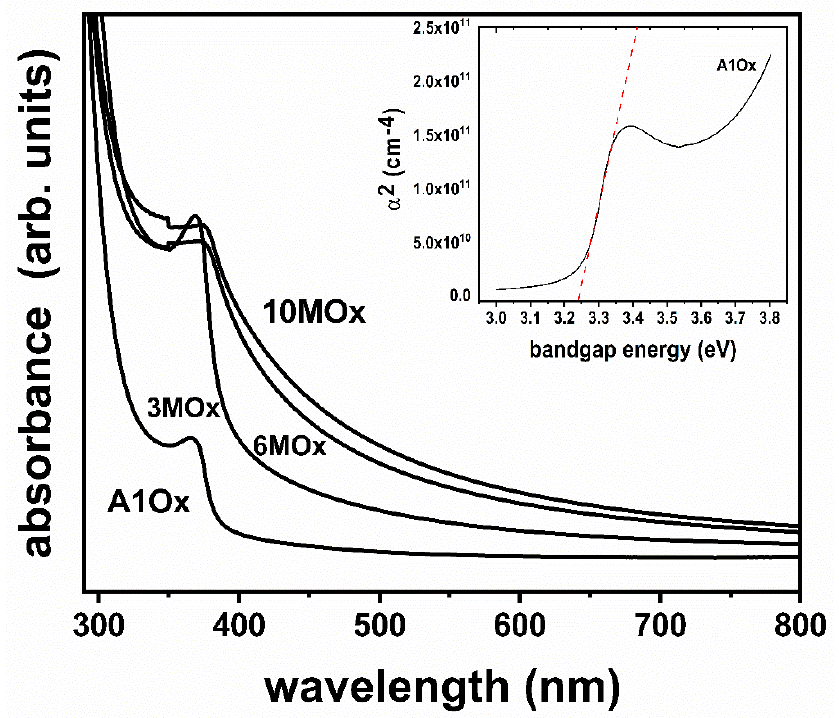
Figure 7. Absorption spectra of ZnO films. The Tauc plot used to determine the fundamental bandgap of sample A1Ox is shown in the inset. See Figure A2 in Appendix A for the Tauc plots of the rest of the